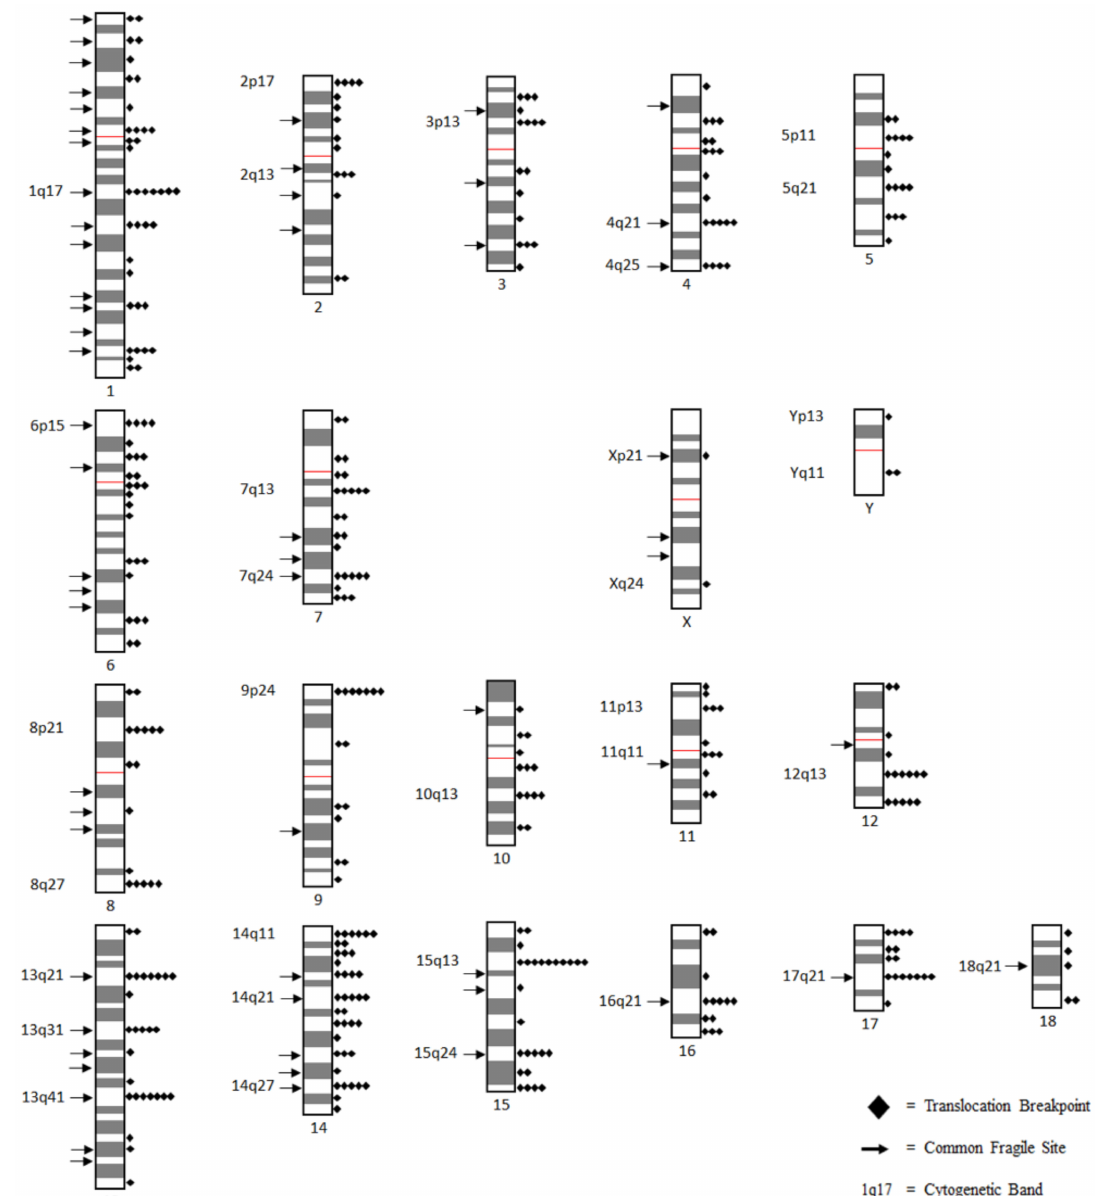
Figure 3. Ideogram of the domestic pig karyotype with important cytogenetic markers displayed. An ideogram of the standard GTG(G-banding using trypsin and giemsa)-banded karyotype of the domestic pig is displayed. Diamonds represent breakpoints on cytogenetic bands. Arrows indicate bands with known common fragile sites. Cytogenetic bands on each chromosome are pointed out, usually those bands with the most breakpoints, to help the positional context of each